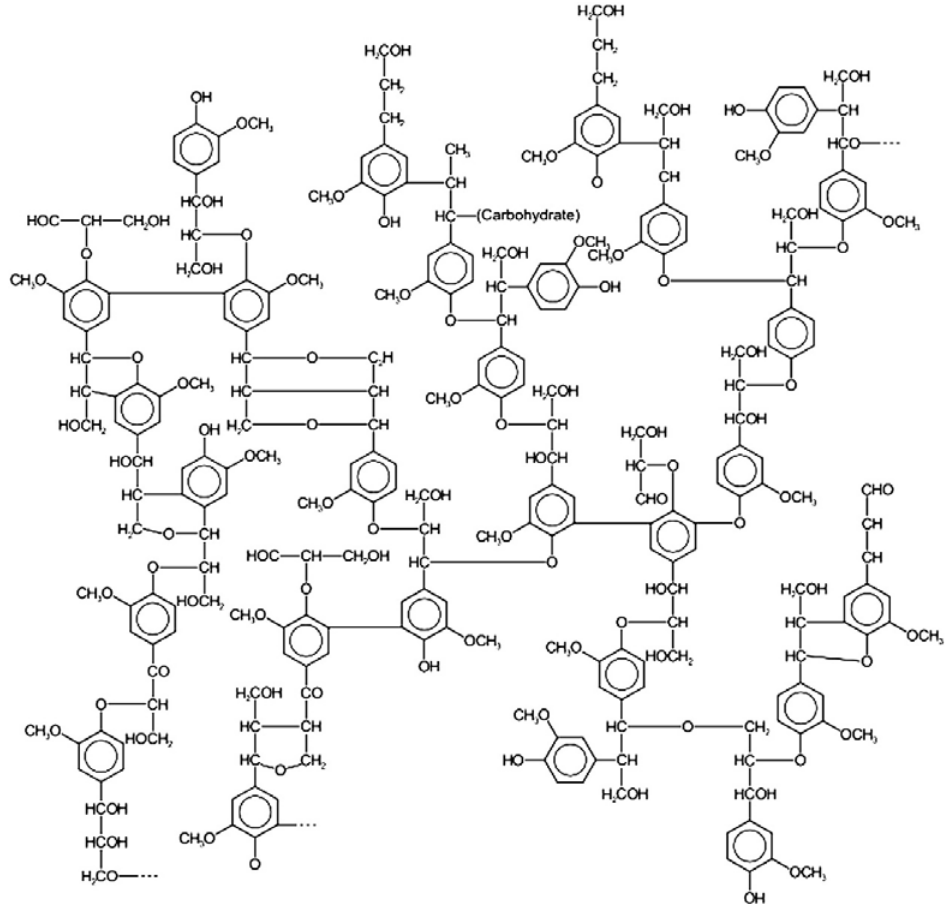
Figure 5. The structure of lignin-carbohydrate complex [16]. Carbohydrate represents polysaccharide portion of lignin–carbohydrate